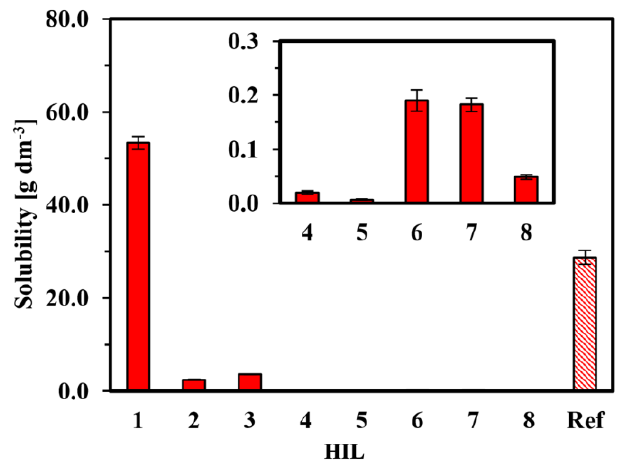
Figure 2. The solubility in the water of the of the obtained ILs ( 1 – 8 ) in comparison to iodosulfuron- methyl sodium salt (Ref).